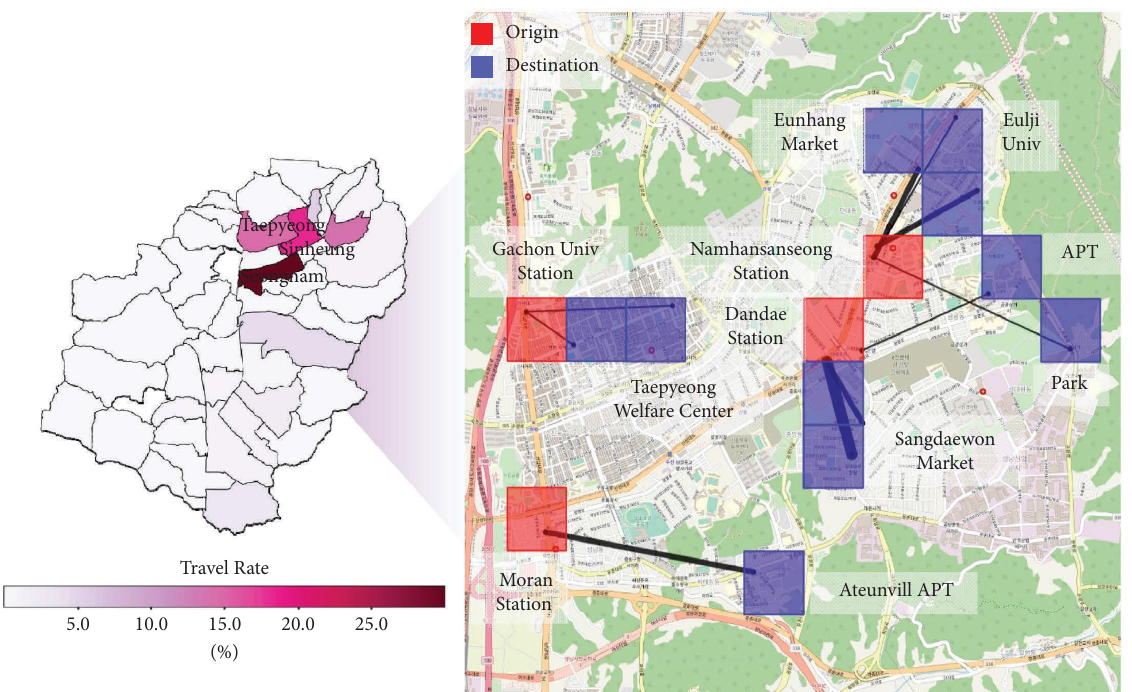
Figure 8: Top ten OD pairs of cluster